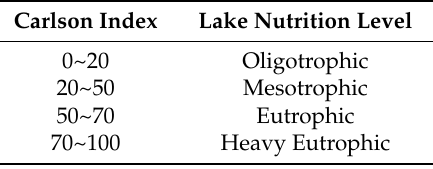
Table 1. Eutrophication Assessment Criteria of TSI M